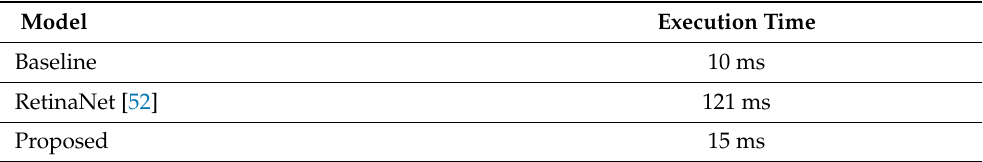
Table 15. Execution time of the proposed approach and the conventional